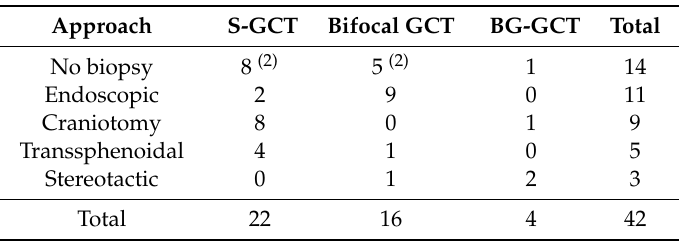
Table 2. Surgery.